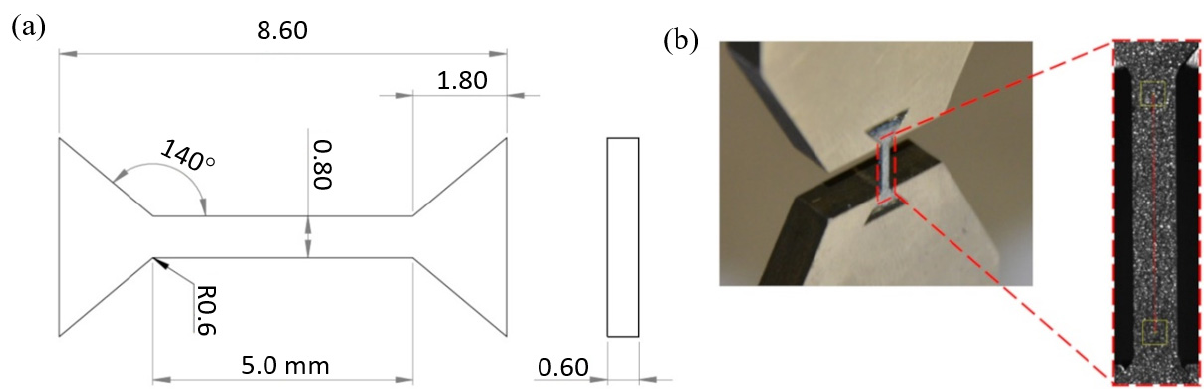
Figure 2. ( a ) Technical drawing of miniaturised tensile sample, and ( b ) its actual view with a schematically presented digital image of its surface used for DIC analysis.